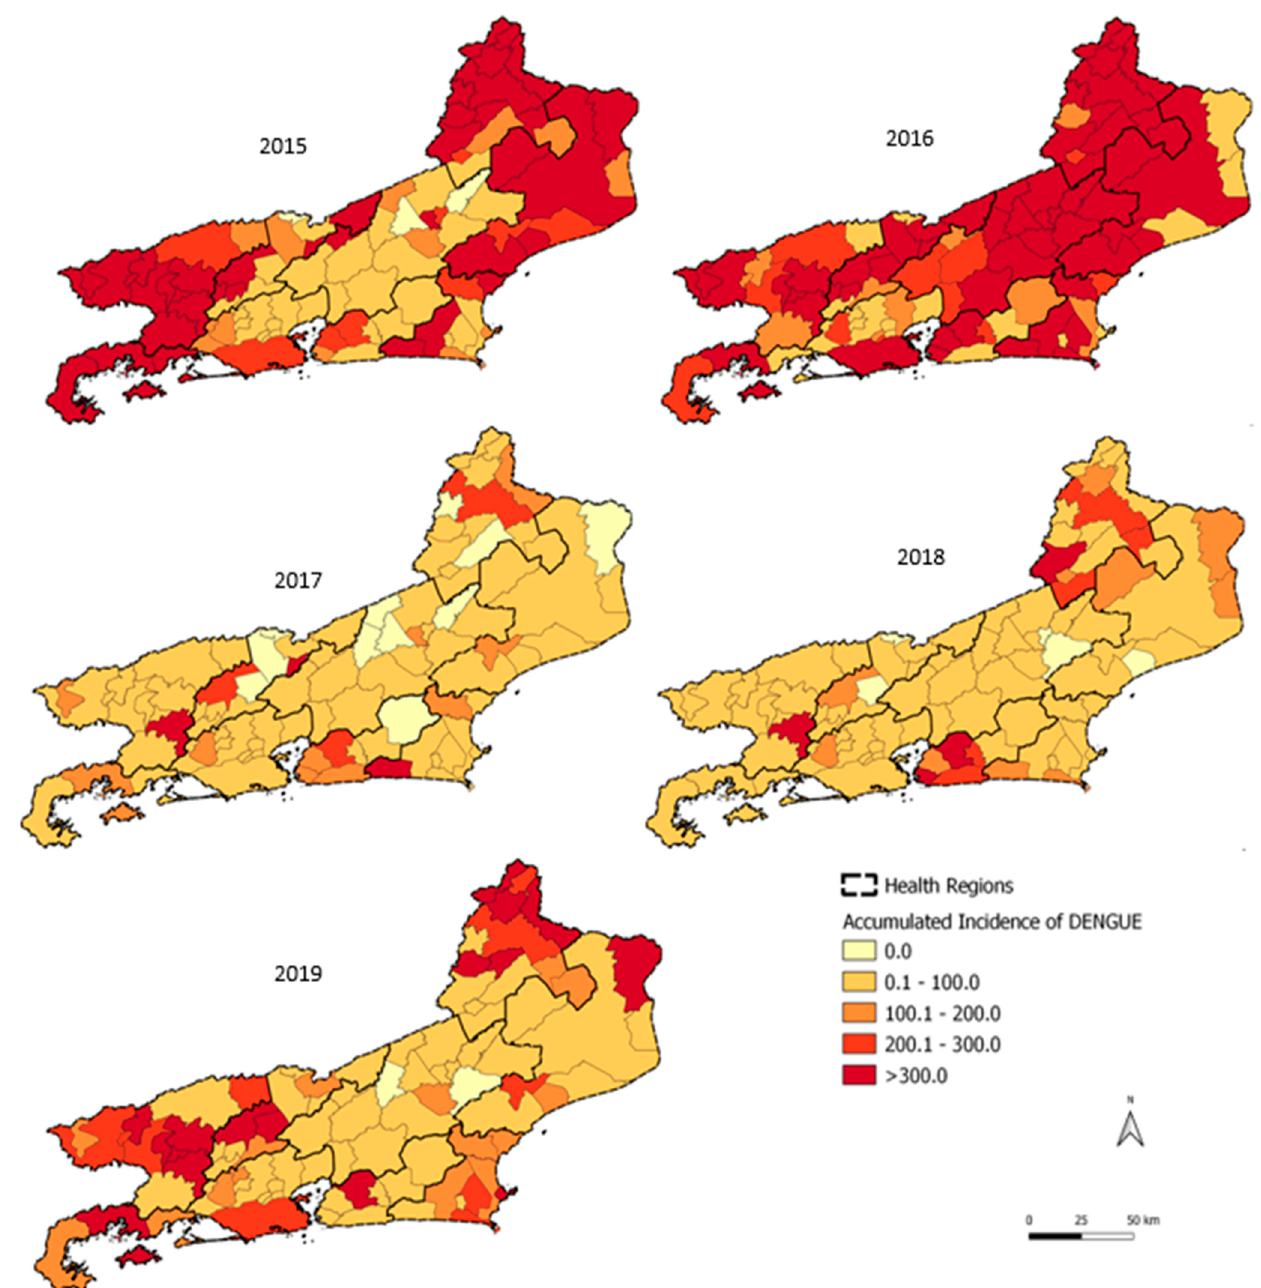
Figure 3. Dengue by year of symptom onset in the state of Rio de Janeiro, 2015–2019.